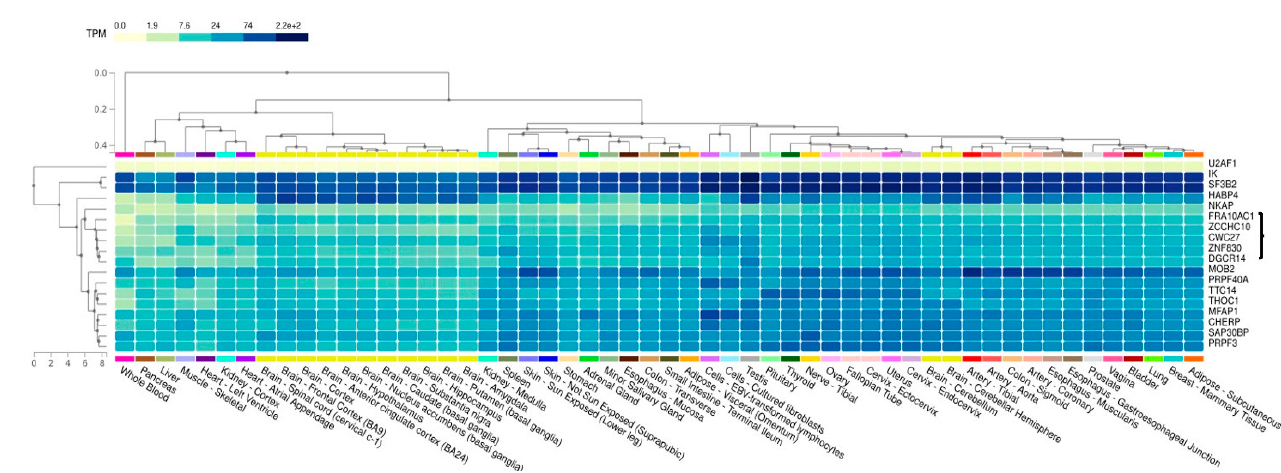
Figure 5. Comparative expression analysis of FRA10AC1 with its interactors genes involved in pre-mRNA processing. The hierarchical clustering of gene transcripts based on the pattern of their median expression across tissues as provided by the GTEx algorithms is shown. FRA10AC1 clusters with ZCCHC10 , CWC27 , ZNF830 , and ESS2 ( DGCR14 ) based on their expression profiles (grouped with a brace), with NKAP sharing a closely related expression pattern. Various groups of tissues share similar expression patterns for these genes, e.g., all brain tissues except cerebellum, the latter showing a relatively higher